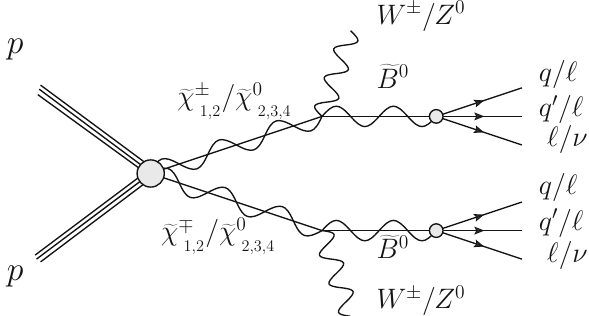
Fig. 12 Production of chargino–neutralino pair decaying to a long- lived bino giving rise to a displaced signal